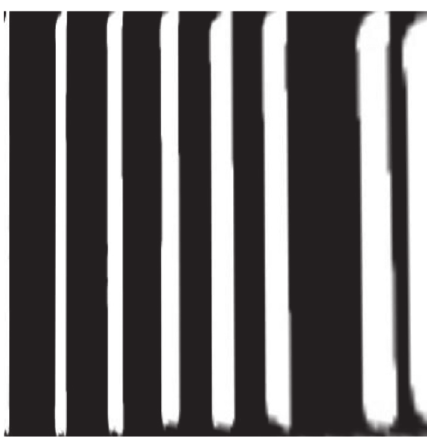
Figure 5: Correction results of the anti-glare panel